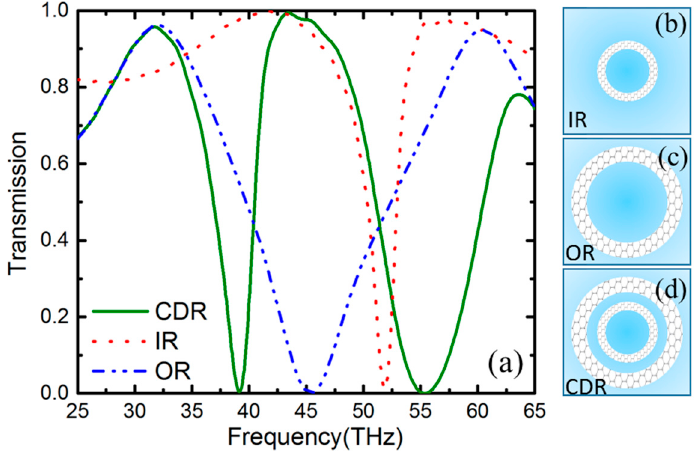
Figure 3. ( a ) Transmission spectrum corresponding to the unit cell with an inner ring (IR), an outer ring (OR) and a concentric-double-ring (CDR). The Fermi energy of graphene is fixed at 0.64 eV and the refractive index of dielectric is set as 1.6 in the simulations. ( b – d ) Structural representation of IR, OR and CDR, respectively.